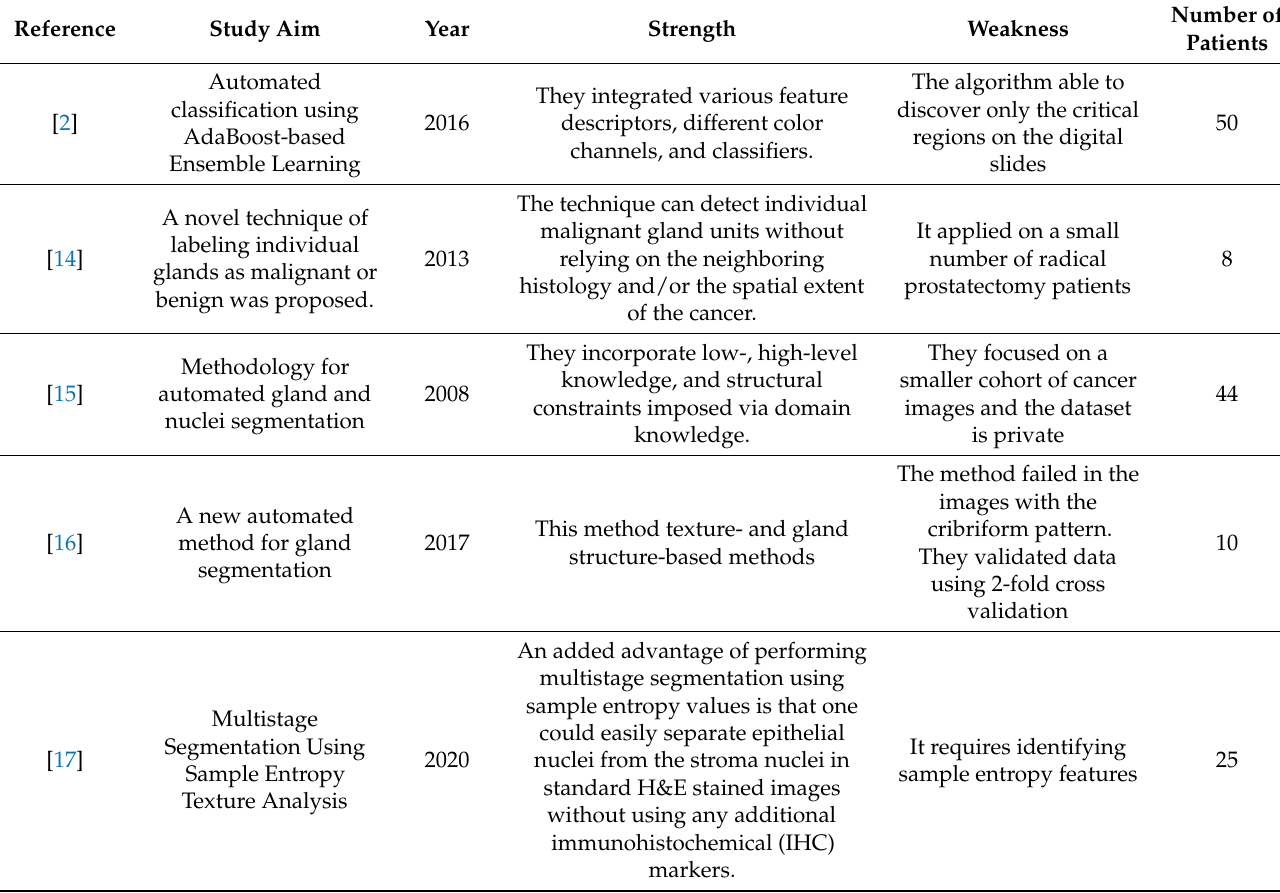
Table 1. A brief comparison between previous studies that proposed techniques for prostate histopathology images.